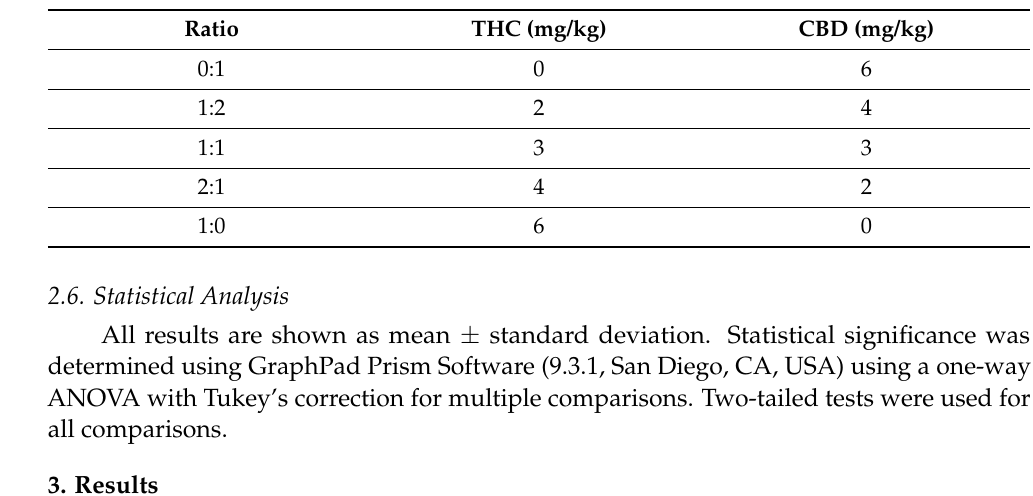
Table 1. Dose of cannabinoid administered at each ratio for pure compounds.